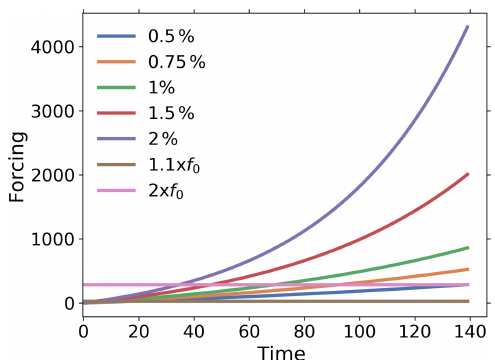
Figure 2. Forcings for the experiments considered in this study. To standardize the type of experiments considered here and in Part 2, we select forcing functions that mimic those employed in climate change simulation experiments to whose data the RFI method is applied in Part 2. Note that in principle any type of forcing could be